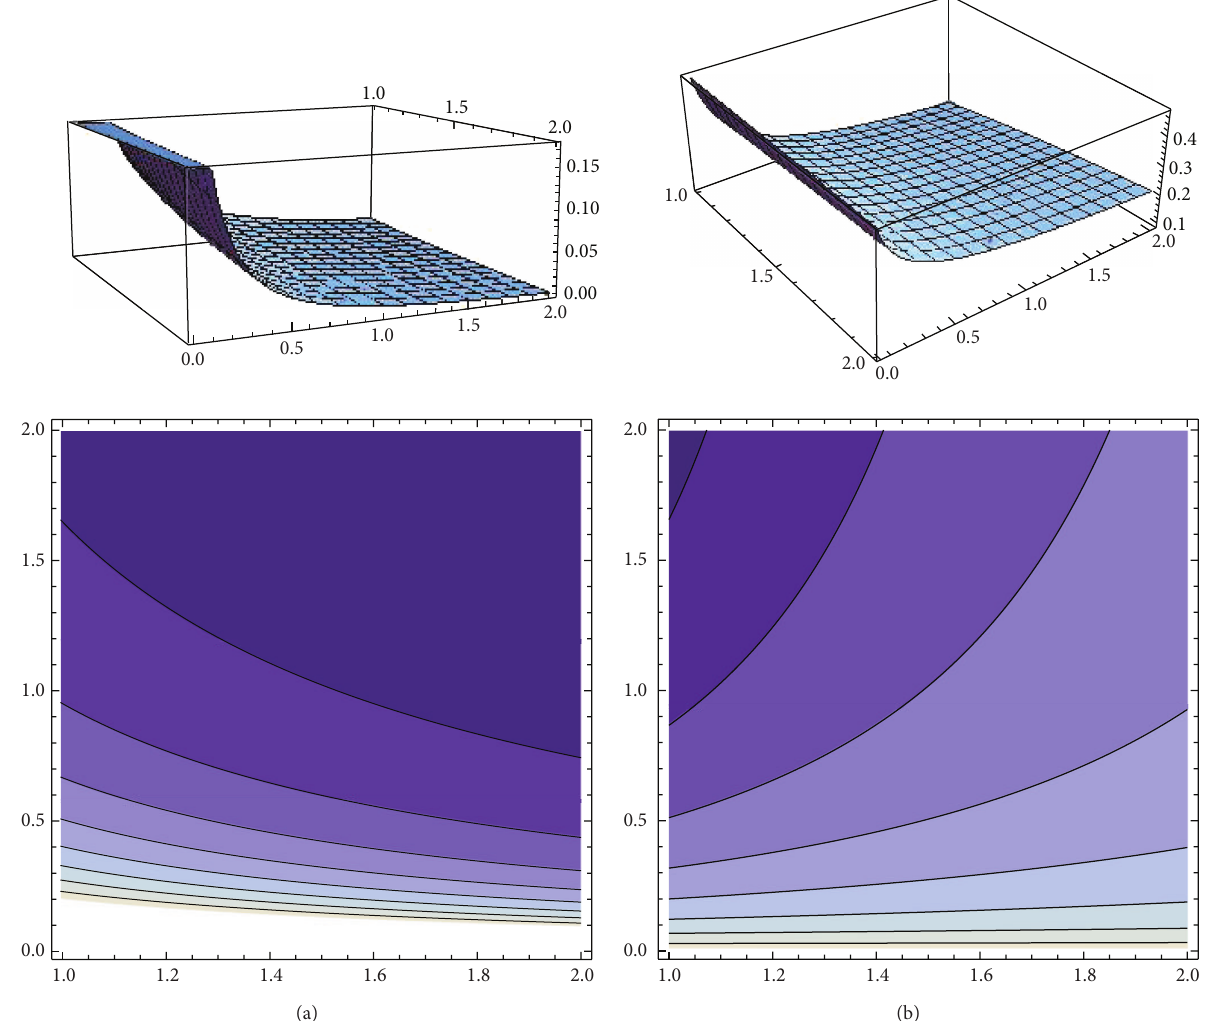
Figure 20: Average profits of firms 1 (a) and 2 (b) when we choose the fixed point which gives us the maximum profit of the first firm 2 among all the fixed points. Note that in projections, the darker the color is, the lower the profit